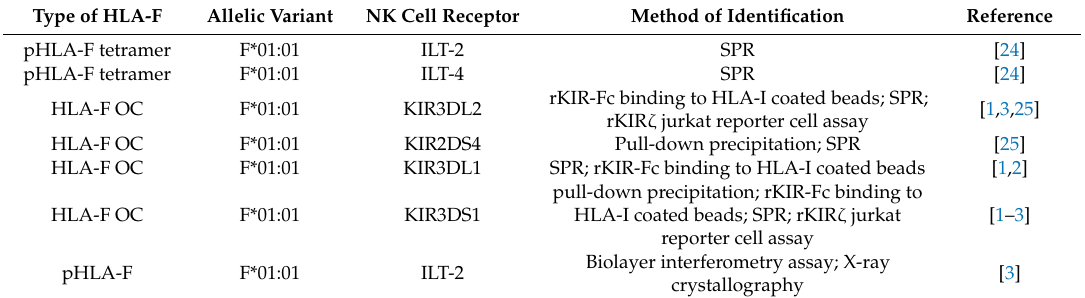
Table 1. Identification methods of interaction between HLA-F and its cognate NK cell receptors.